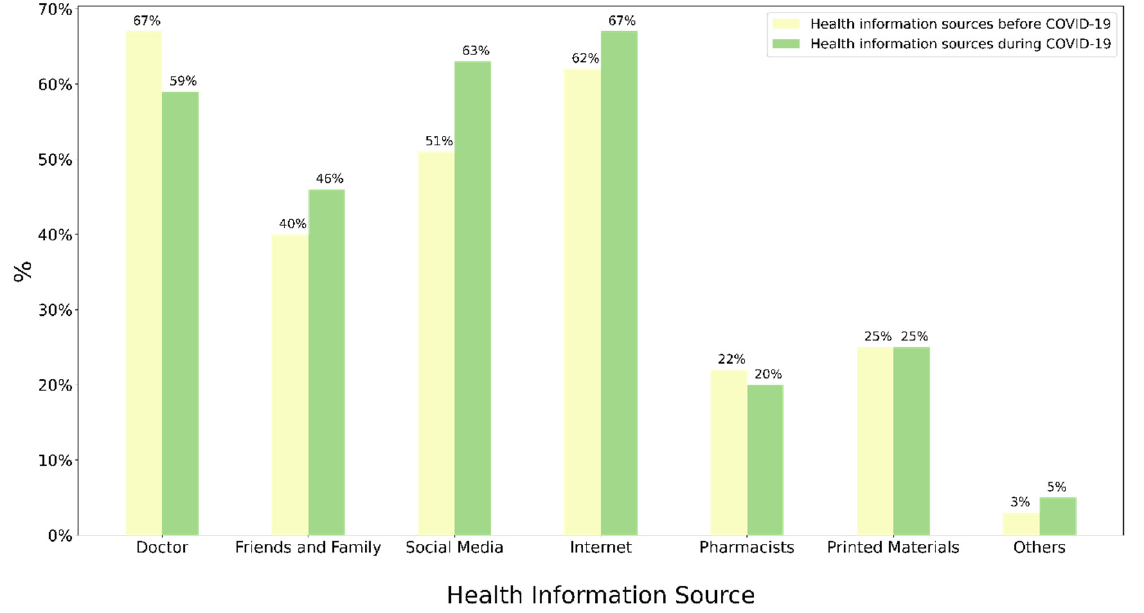
Figure 1. The distribution of health information resources usage before and after the COVID-19 pandemic.